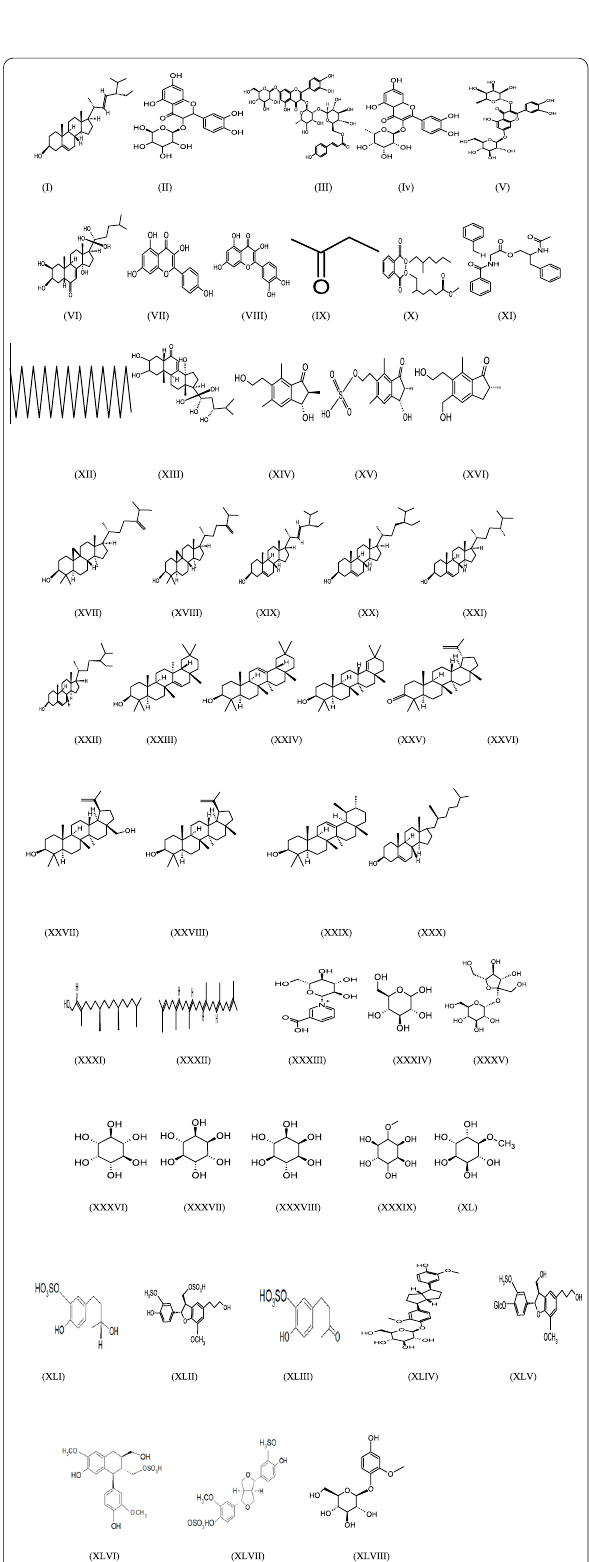
Fig. 3 Chemical structures of isolated and identified compounds in Acrostichum